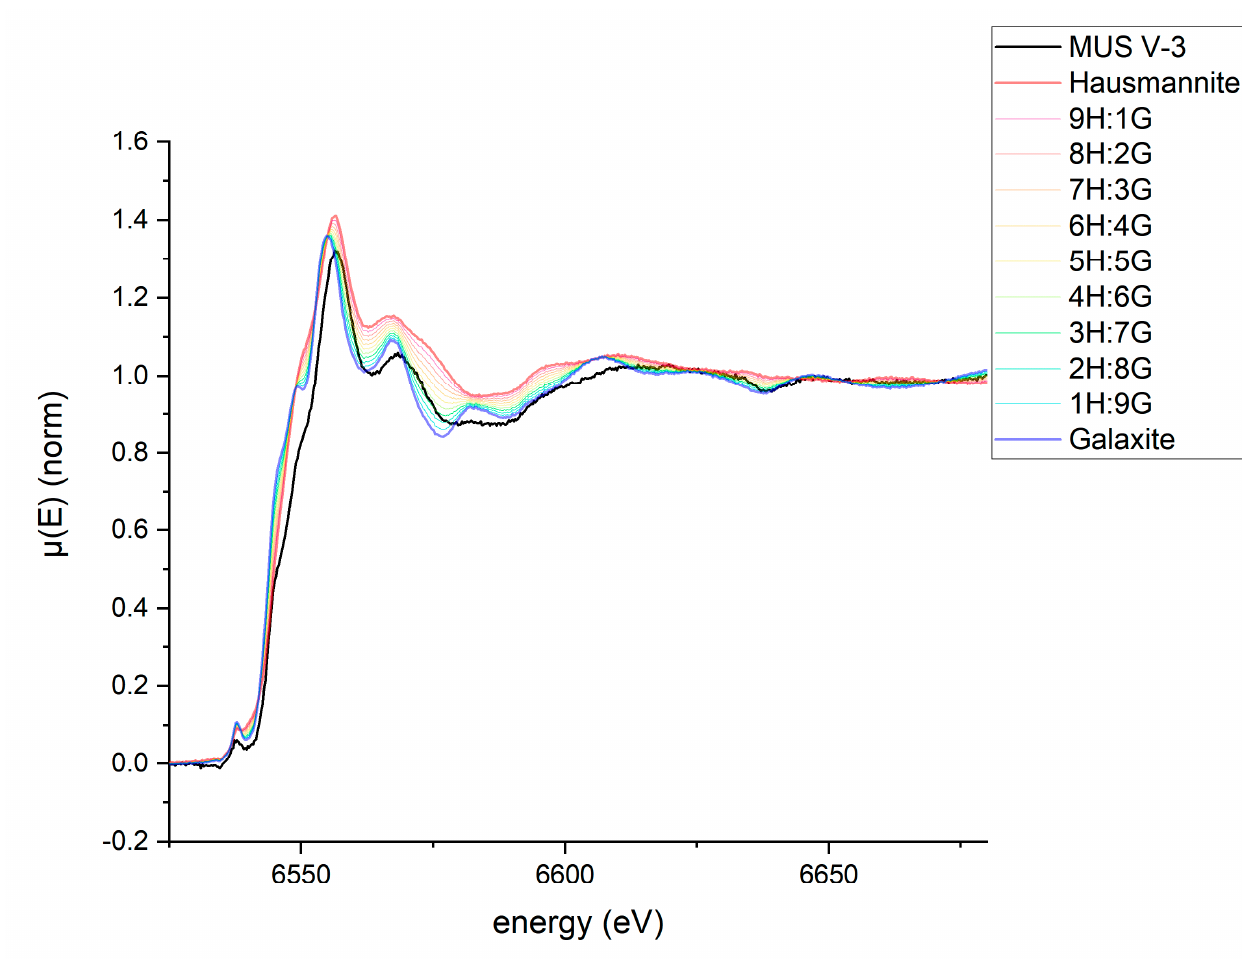
Figure 7. Linear combination of hausmannite (H) and galaxite (G). At the edge jump, the MUS spectrum fits the spectrum of hausmannite, whereas after the jump, the spectrum is more similar to galaxite.